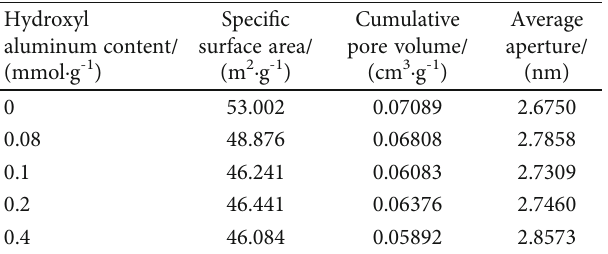
Figure 13: X-Ray di ff raction pattern of soil samples with di ff erent contents of hydroxyl aluminum. Table 5: Changes of speci fi c surface area and pore size of hydroxyl aluminum-modi fi ed